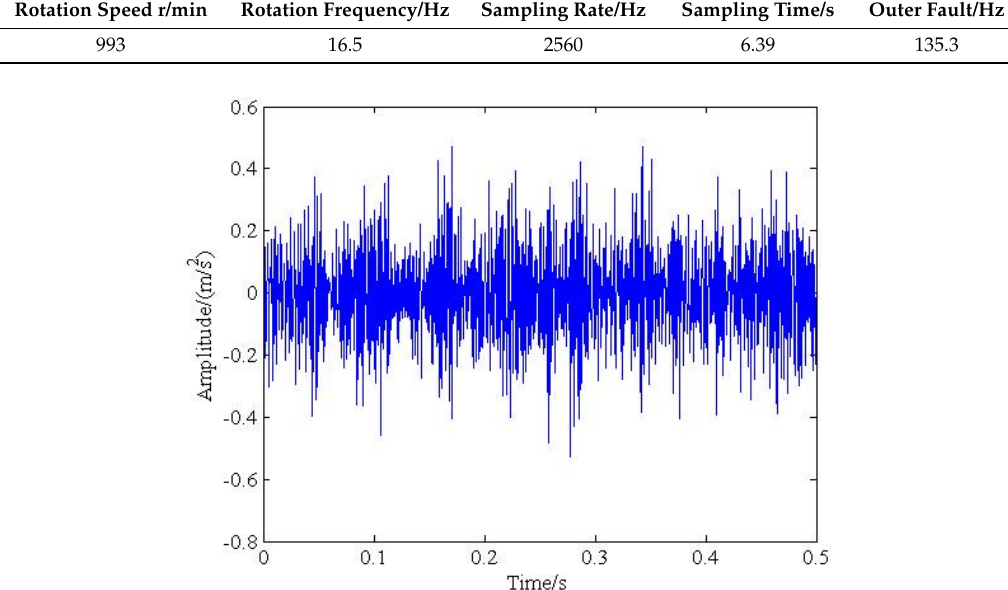
Figure 8. The measured vibration signal of an exhaust fan in time ‐ domain.